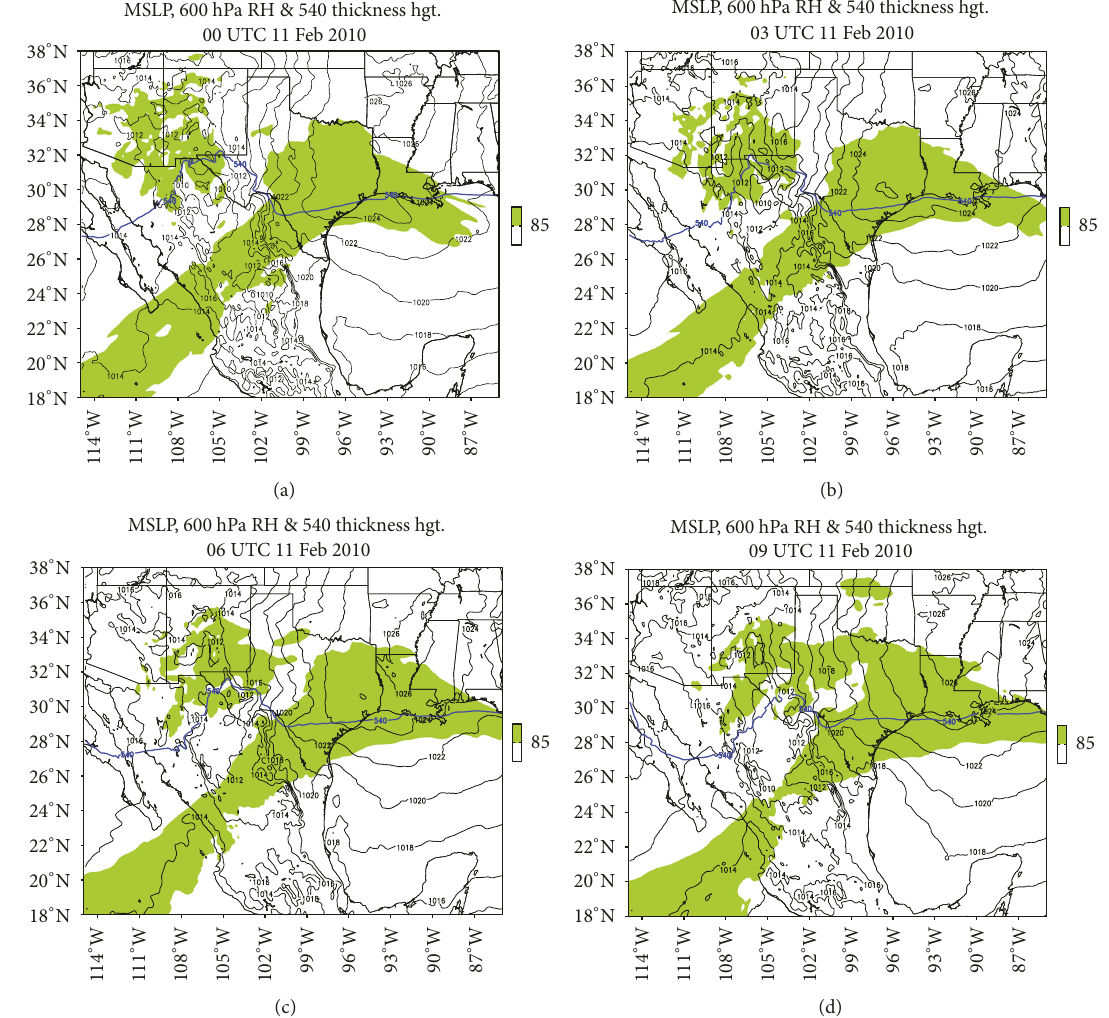
Figure 11: Simulated (12 km) mean sea level pressure (in hPa) 600 hPa relative humidity and 540 dam contour of the 1000–500 hPa thickness on (a) 0000, (b) 0300, (c) 0600, and (d) 0900 UTC 11 February